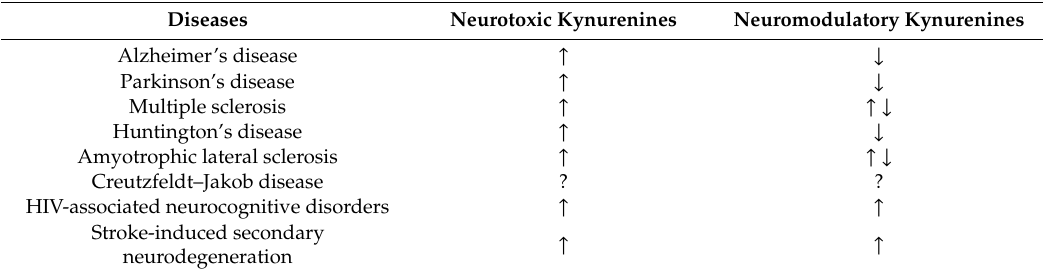
Table 2. Systematic synthesis of neurotoxic and neuromodulatory kynurenine levels in neurodegenerative diseases. ↑ : increase; ↓ : decrease; ↑ ↓ : mixed result; ?: